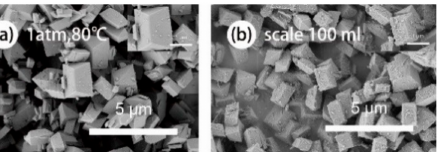
Figure 6. SEM images of ( a ) MIL-121-1 atm, 80 ◦ C, ( b ) MIL-121-scale 100 mL.